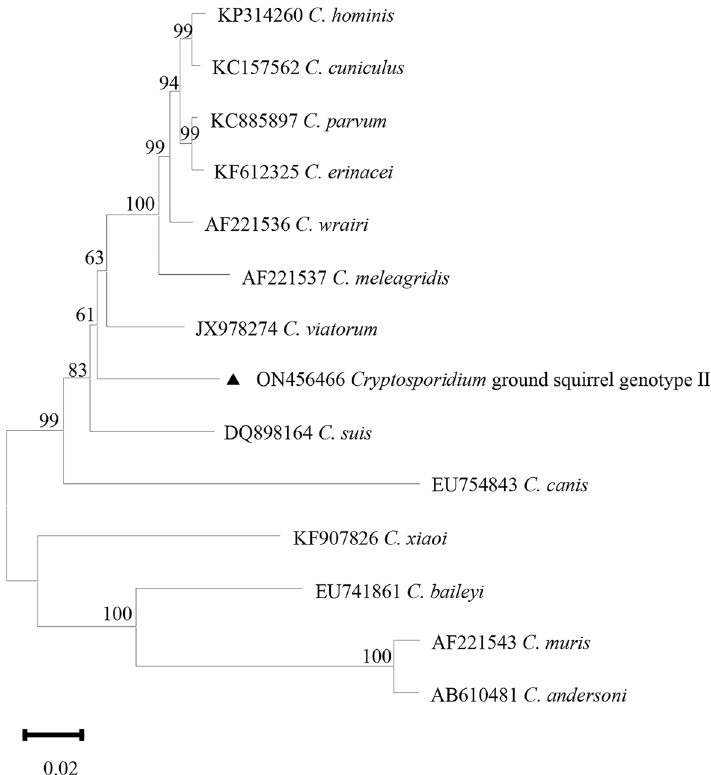
Figure 4. Phylogenetic relationship among Cryptosporidium spp. based on a neighbor-joining tree of the HSP70 gene. The numbers on the branches are percent bootstrapping values from 1000 replicates, and the sequences generated in the present study are indicated with the triangles.